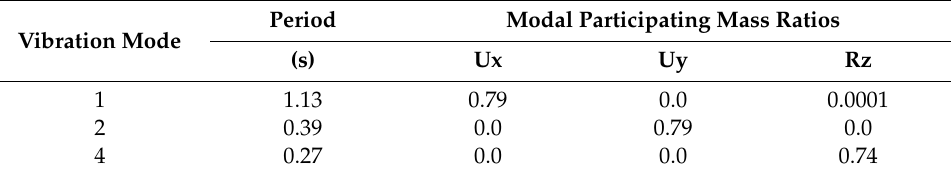
Table 3. Modal parameters of the central block of building B.